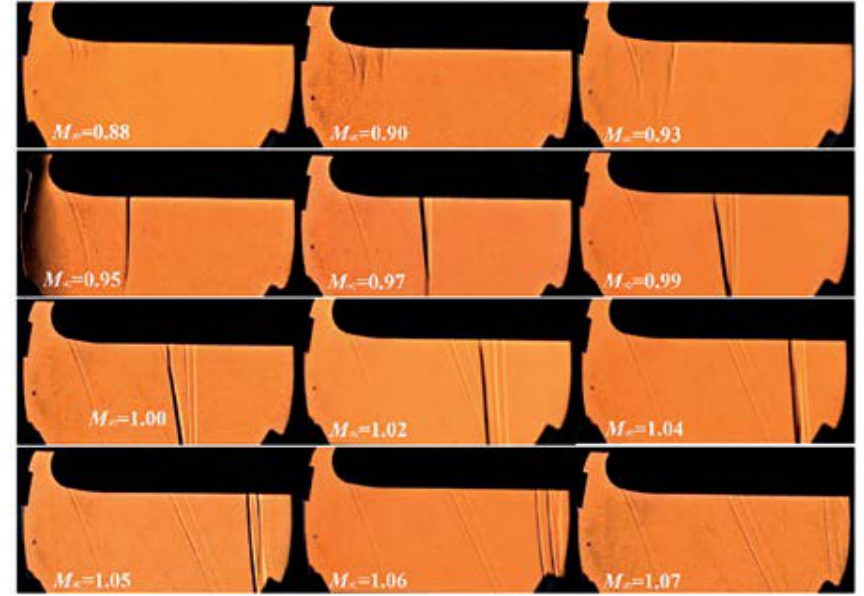
Figure 13. Schlieren images for model tangent–hemispheric forebody with a blockage area ratio of 0.78% for a stagnation pressure of 80 kPa and a stagnation temperature of about 300